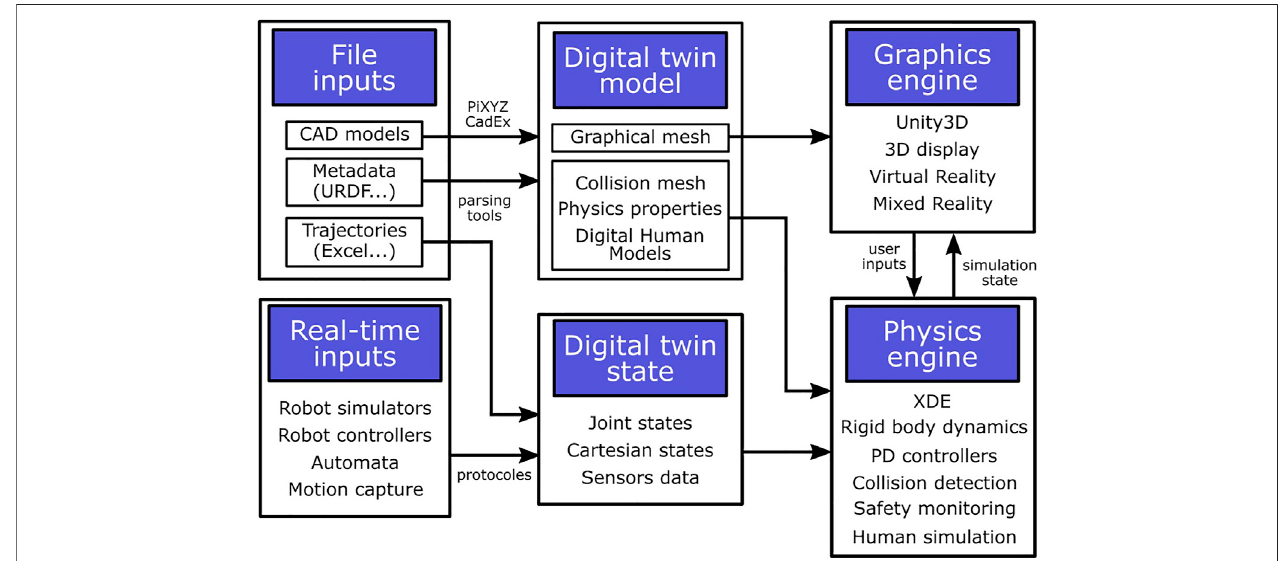
FIGURE 1 | Global architecture to model, animate and display a physics-based digital